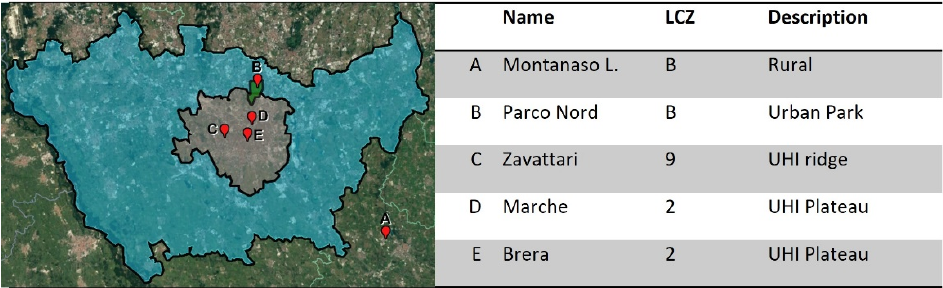
Figure 1. Position of the five weather stations. Blue area = metropolitan city; grey area = Milan municipality; green area = Parco Nord.